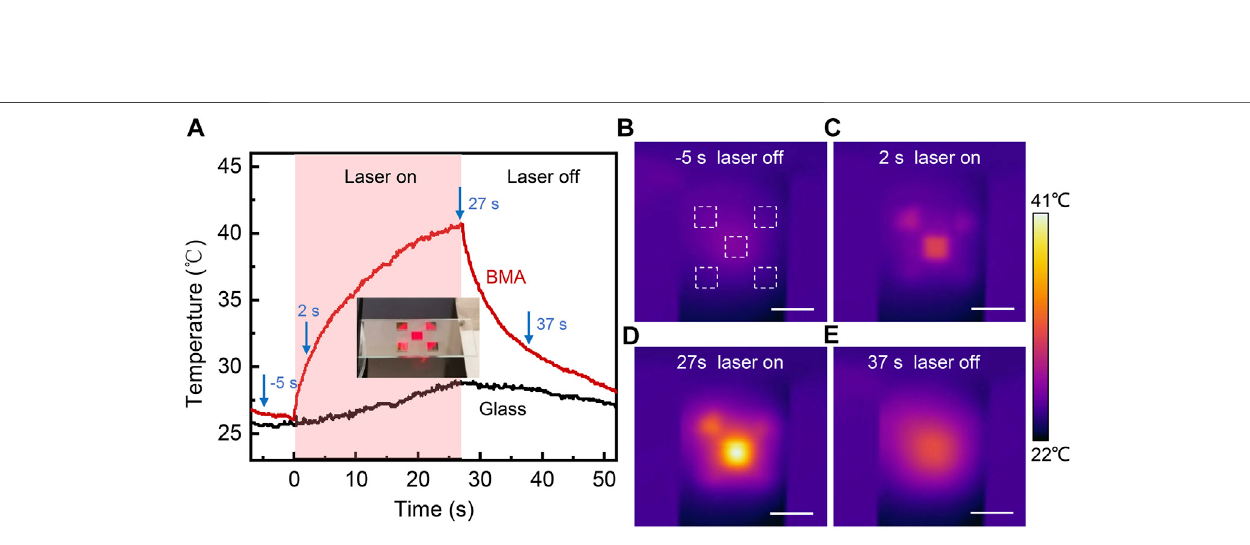
Frontiers in Physics |